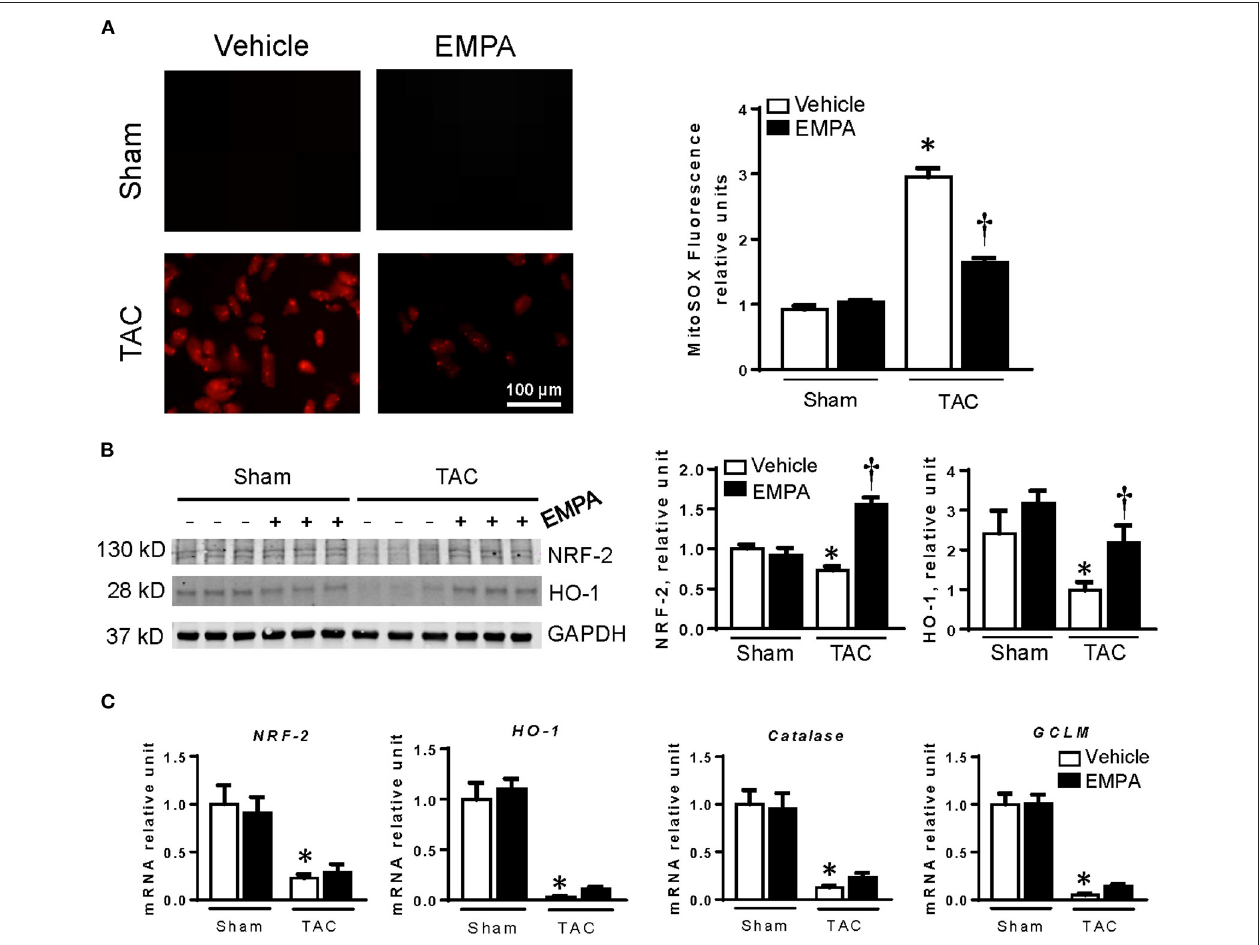
FIGURE 2 | EMPA treatment attenuated cardiomyocyte overproduction of reactive oxygen species (ROS) induced by TAC. (A) Left, Mitosox staining of cardiomyocytes in sham, sham + EMPA, TAC and TAC + EMPA groups and Right, quantitative results. (B) Representative blots of NRF-2 and HO-1, and quantitative results. (C) The relative mRNA levels of genes related to endogenous antioxidants. Results are expressed as mean ± SEM, n = 5–7, * p < 0.05 vs. corresponding sham group, † p < 0.05 vs. corresponding TAC vehicle group. One-way ANOVA and Tukey post hoc test. EMPA, empagliflozin; SEM, standard error of the mean;